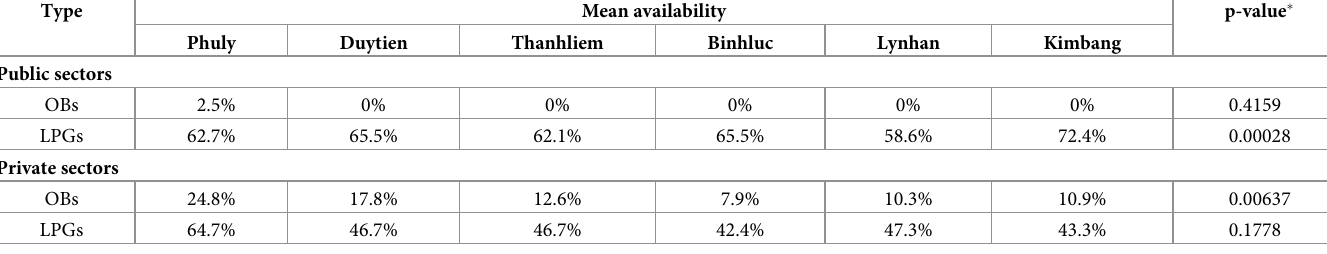
Table 3. Regional analysis: Comparison of the mean availability of EMs across the six regions surveyed.